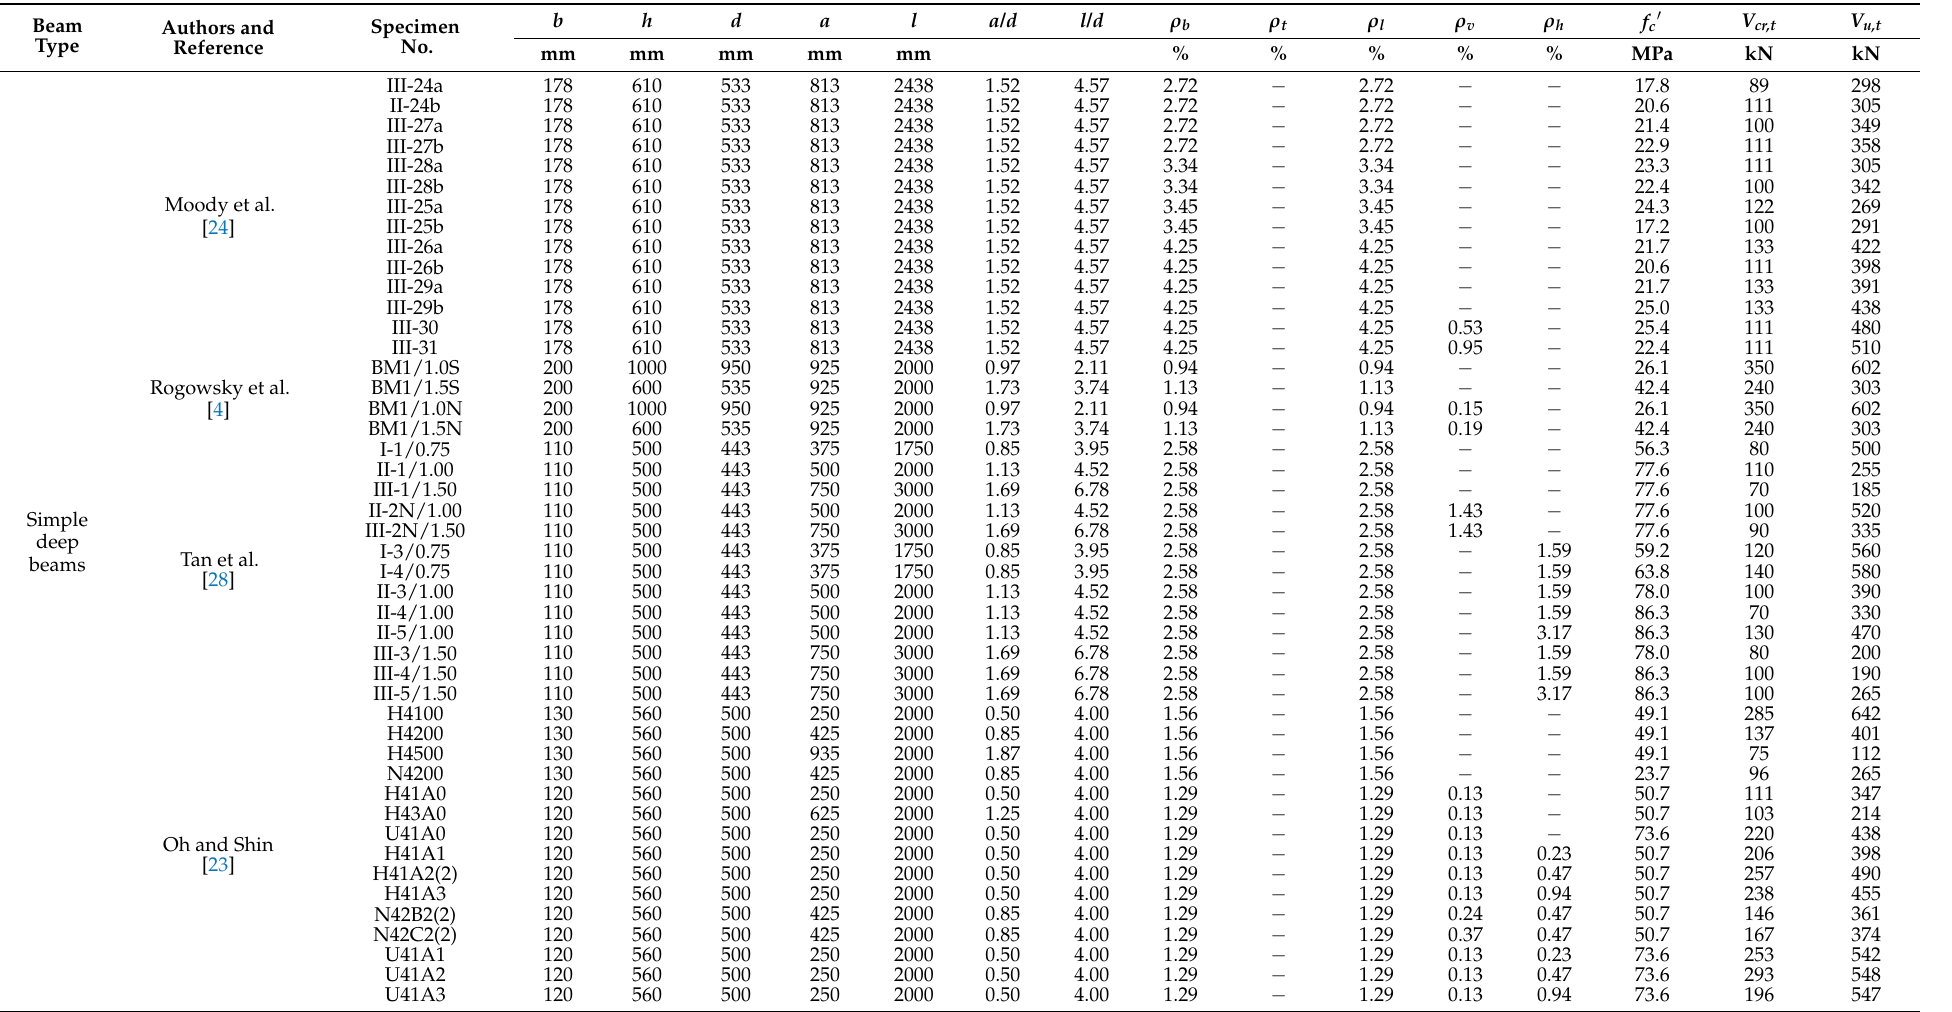
Table 1. Database for diagonal tension cracking strength evaluation of simple and continuous deep